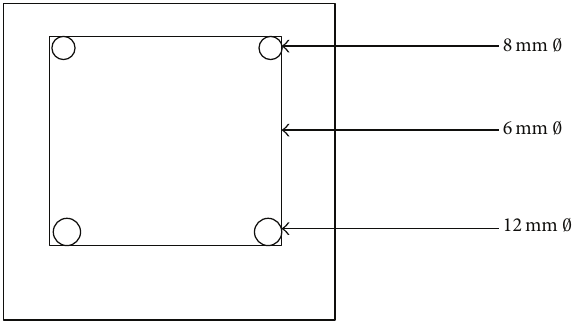
Figure 2: Cross section of